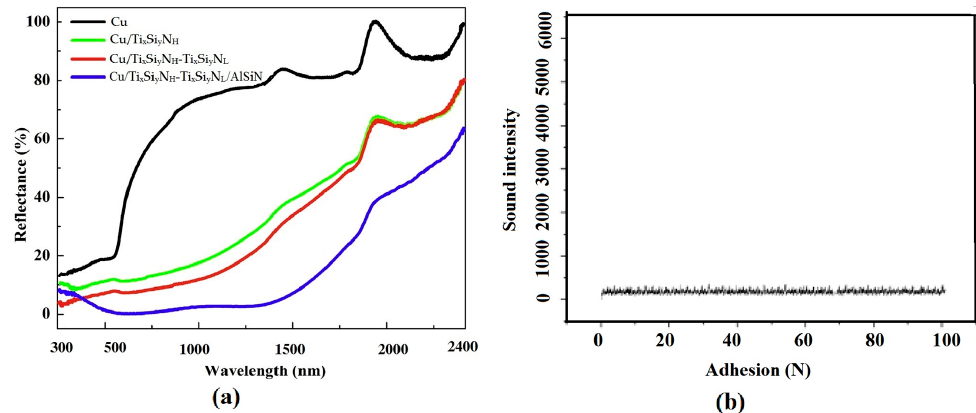
5 of 10 Figure 2. ( a ) Schematic diagram, and ( b ) cross-section microstructure of solar selective coatings (SSC). Interfacial bonding strength is one of the most important properties of the coating [26]. The wear resistance, oxidation resistance and service life of the coating are directly related to it. A scratch test is a quantitative method for testing interfacial bonding strength [26]. The critical load appears on the acoustic signal curve as the start of the spike. Figure 3b shows that during the increase of N from 0 to 100 N (N max = 100 N, maximum load of automatic scratch tester for coating adhesion of WS-2004), the acoustic signal curve is basically a smooth curve, and no sudden peak appears. It shows that the coating had excellent adhesion on stainless steel substrate. Table 2. The absorptance, emittance, and solar selectivity values. Layer